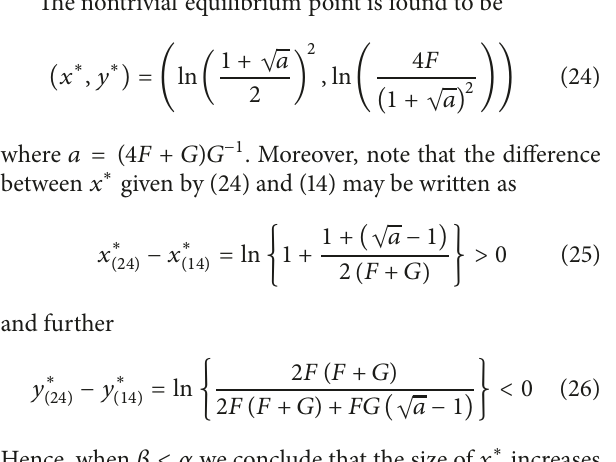
Figure 3: Below the curve is the fraction of all orbits starting at 20000 different initial conditions (𝑥 towards attractor 𝐴2 . 𝐺 = 4 , 10 < 𝐹 < 80